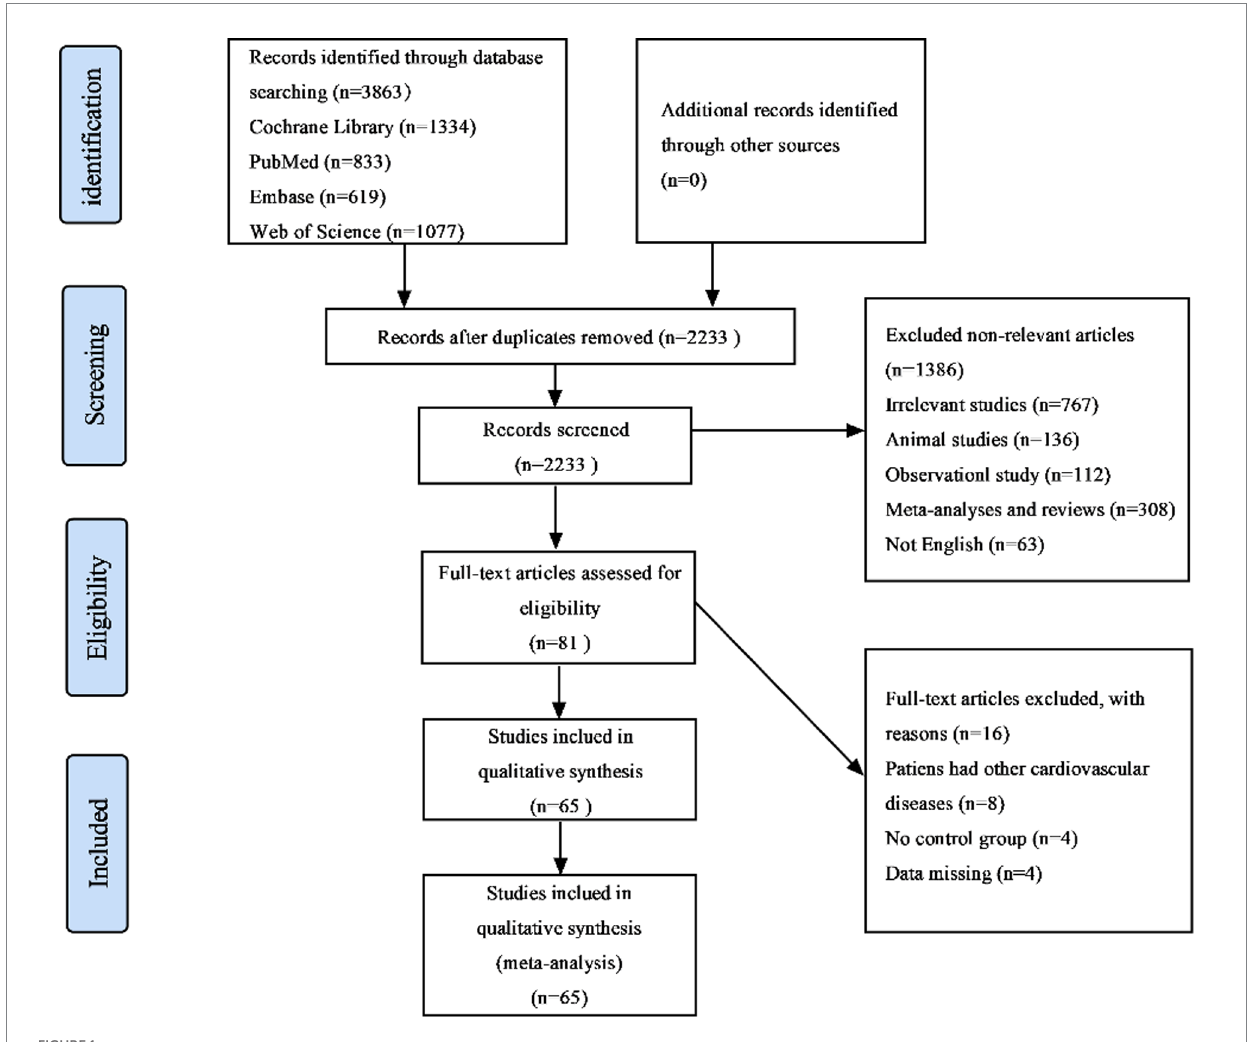
FIGURE 1 PRISMA flow diagram of selection of studies from search to final